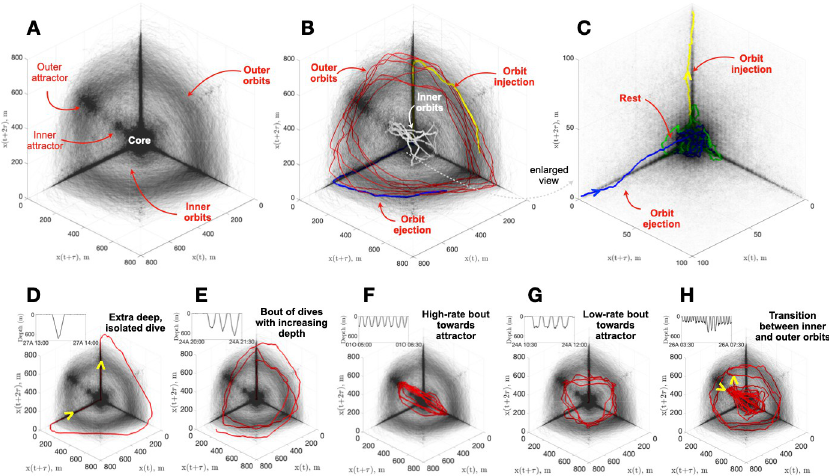
Fig 1. Diving behavior state–space revealed by time-delay embedding. (A) The locus of the vortex (the “core”) is the main attractor of the system with inner and outer orbits having secondary attractors, with a gap between. (B) The most stereotypical trajectories, such as transitional injection into outer orbits (yellow), strongly oscillatory regions of outer orbits representing a deep-dive bout (red), transitional ejection back to the core (blue), and a secondary type of oscillatory region along inner orbits representing a shallow-dive bout (white). (C) Zoomed view of subpanel B, highlighting the “rest” state near the origin (green), and pathways toward outer orbits and back. Different examples of narwhal diving repertoire such as (D) isolated deep dive; (E) a telescopic spiral due to gradual change of maximum depth of each dive (outward or inward depending on the sign of change); (F, G) repeated visits to outer attractor with different rates; and (H) a transition between two orbitals (yellow arrows show inward and outward entries into a particular